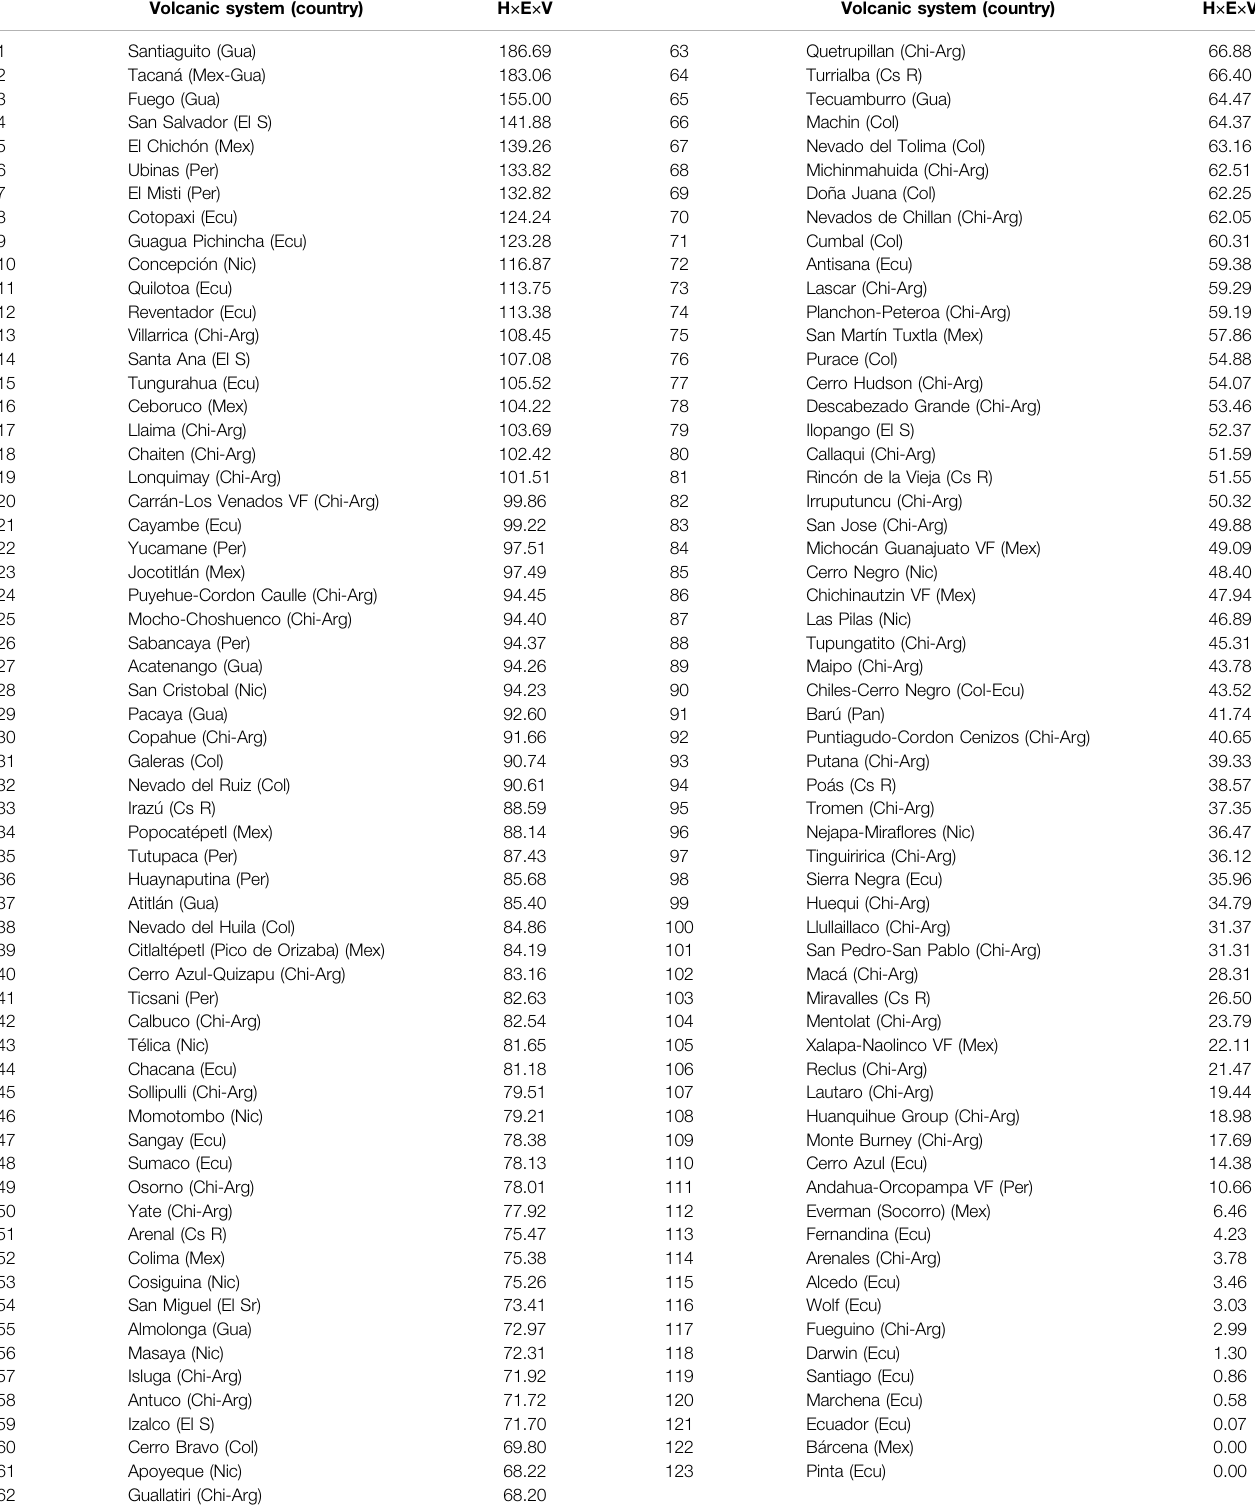
TABLE4| VRR(1)fortheLatinAmericavolcanicsystemswithrecordedactivityinthepast1,000years.Thecompletetableofresultswiththescoreofallfactorsisavailablein the Supplementary Material 1